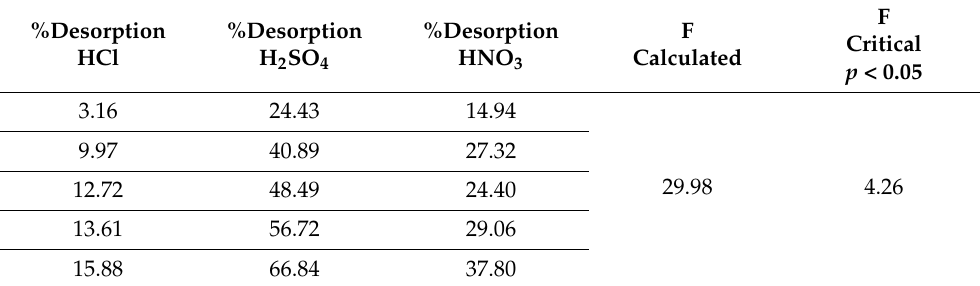
Table 2. Analysis of variance between extractant solutions for Cr(III).